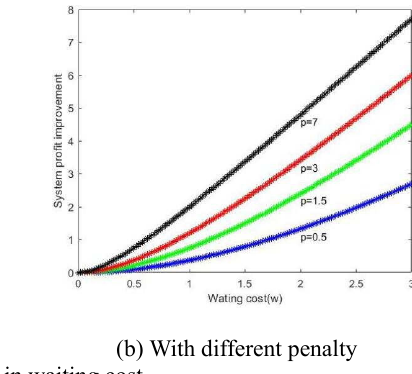
Fig. 7. Profit improvement in waiting